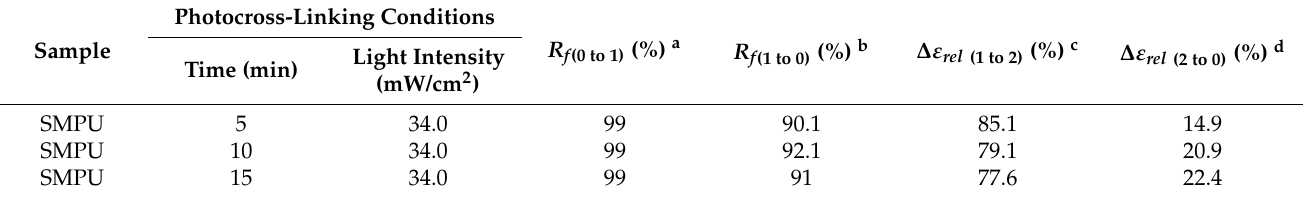
Table 3. Triple-shape-memory properties of shape-memory polyurethanes (SMPU) containing coumarin moieties.